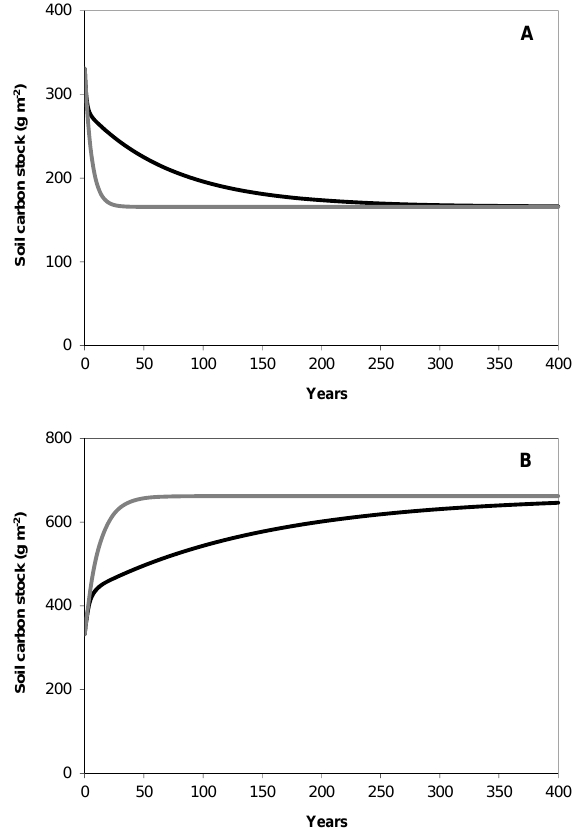
Fig. 3. Change in soil carbon stock (gm − 2 ) after (A) doubling of decay rates (or 50% decrease in turnover times), and (B) doubling of NPP inputs for the two-pool (black line) and one-pool (grey line) models. For the two-pool model, the turnover time data are for sandstone 0–15cm light fraction, in which 30% of the fraction has τ = 4yr and 70% has τ = 150yr (Table 4). The one-pool model has a single turnover time (12.6yr) and gives the same total soil CO 2 flux (26.4gm − 2 yr − 1 ) from a stock of 331gm − 2 in steady state as does the two-pool